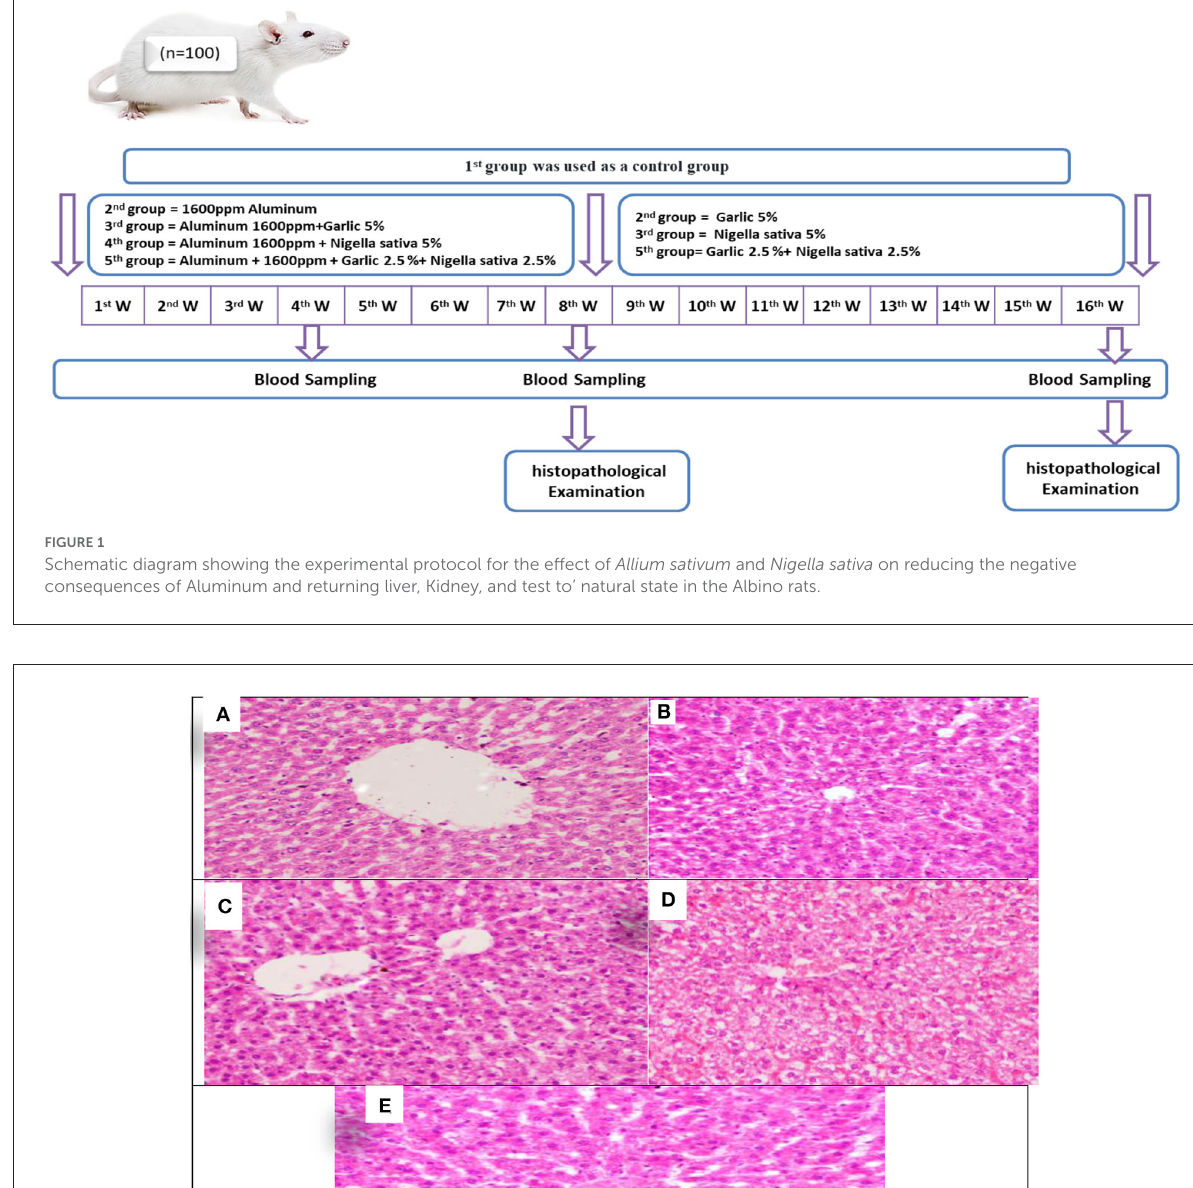
with medicinal plants Allium sativum 5% , Nigella 5%, and the mixture between them ( Allium sativum 2.5% + Nigella 2.5%), showed average results in Kidney samples. Sections in the kidney tissue showed preserved architecture; the cortex revealed normal glomeruli and tubules, and the medulla